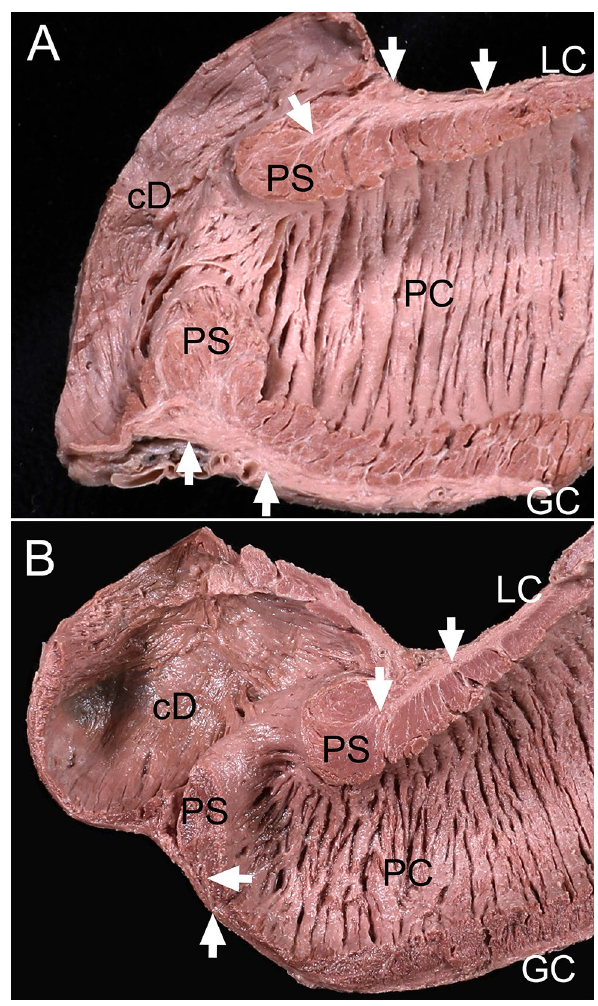
Figure 1. The thickest longitudinal muscle bundles at the pyloric sphincter (PS) wall and the longitudinal bundles entering the PS. ( A ) The longitudinal bundles (arrows) of the stomach became thicker at the pyloric canal (PC) wall, especially on the side of the lesser curvature (LC), and the longitudinal bundles (arrows) were the thickest at the PS wall in a longitudinal section through the PS wall including the LC and greater curvature (GC). ( B ) Some longitudinal bundles (arrows) entering the PS in a longitudinal section of the PS were cut including the LC and GC. The longitudinal bundles were more prominent in the PS on the LC side than the GC side. cD circular bundles of the